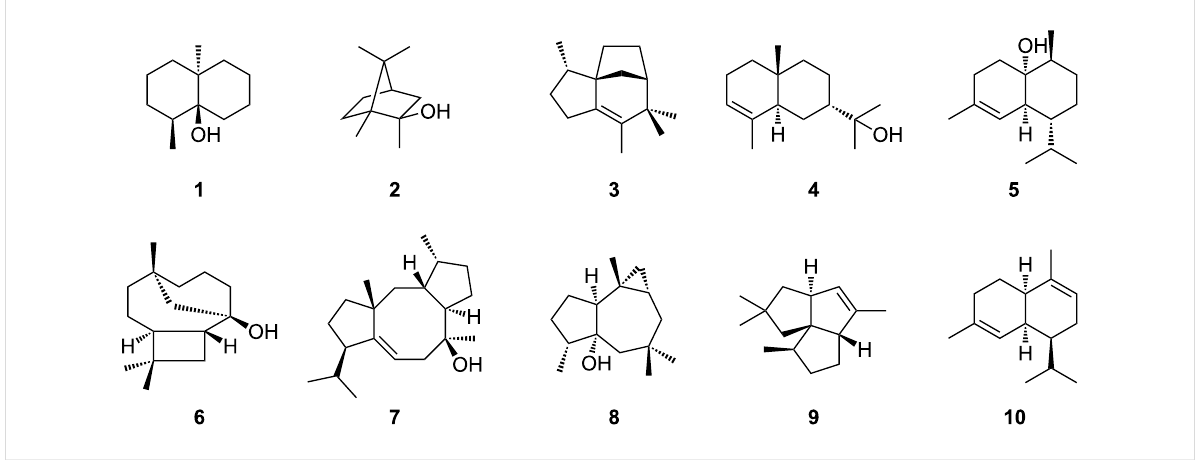
Figure 2: Structures of the products of the ten most abundant terpene synthases in Streptomyces .